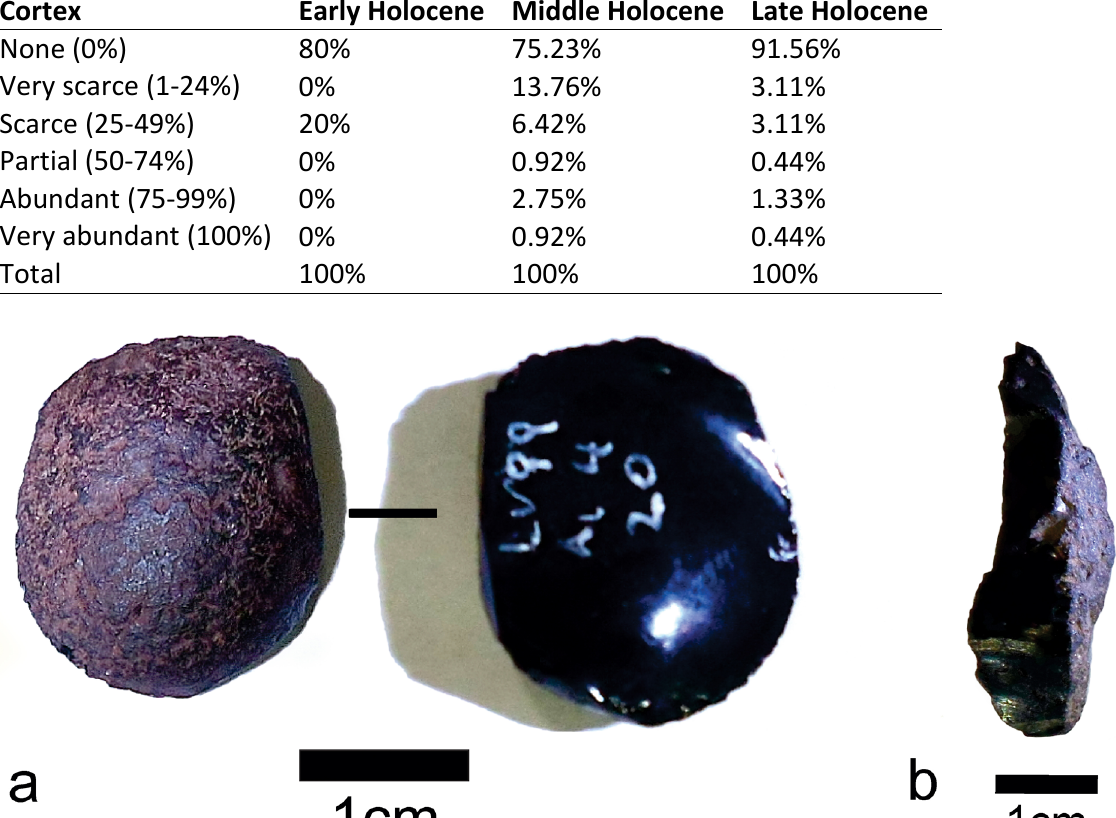
Table 6. Amount of cortex in flakes from each occupation period.